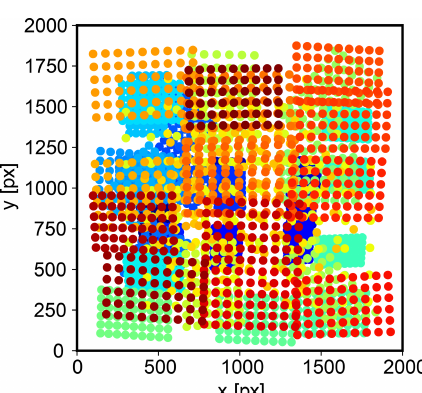
Figure A1. Locations of each chessboard corner during calibration on the image sensor plane.